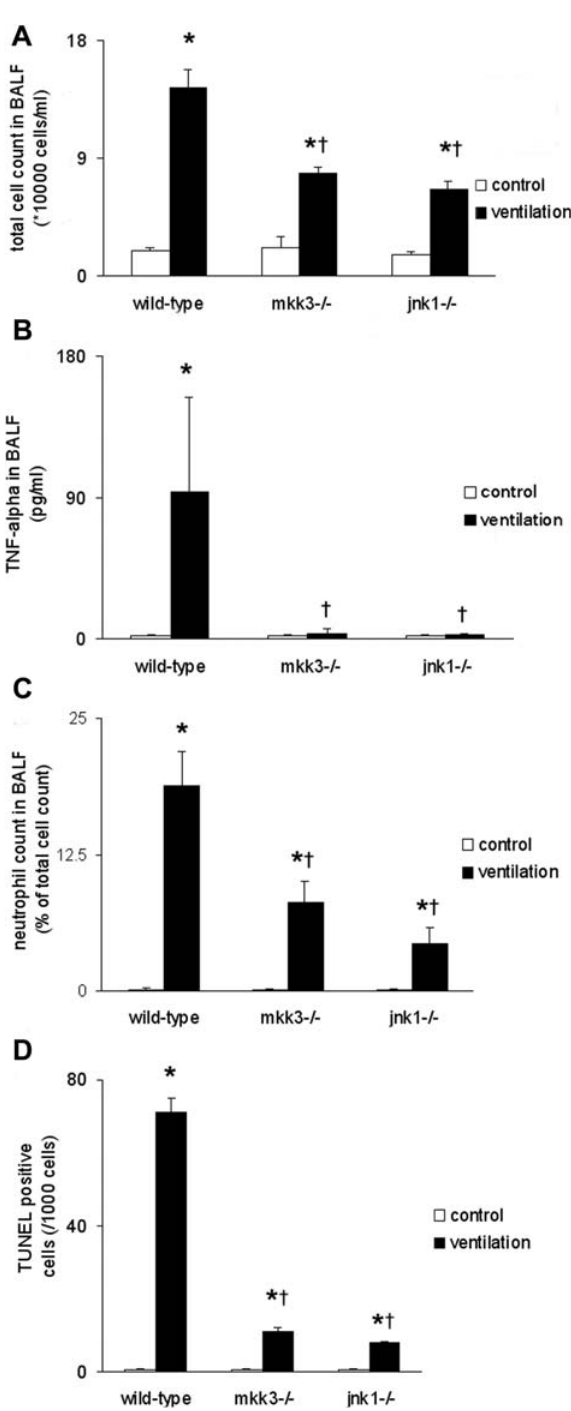
Figure 5. Lung injury and cell death measurement in wild-type, mkk3 2 / 2 and jnk1 2 / 2 mice. (A) Reduced total cell count was detected in genetically deficient mice following ventilation (20 ml/kg, 4 hours). (B) Tumor necrosis factor- a levels were reduced in genetically deficient mice after ventilation (20 ml/kg, 2 hours). (C) Neutrophil levels were lower in genetically deficient mice following ventilation (10 ml/kg, 8 hours). (D) Quantified TUNEL staining for cell death showed that wild-type mice have increased cell death when compared to mkk3 2 / 2 and jnk1 2 / 2 mice following volume ventilation (10 ml/kg, 8 hours). Values expressed as number of TUNEL staining cells/1000 cells. *represents significant differences between control and ventilated animals, { represents significant differences between wild-type and genetically deficient animals.